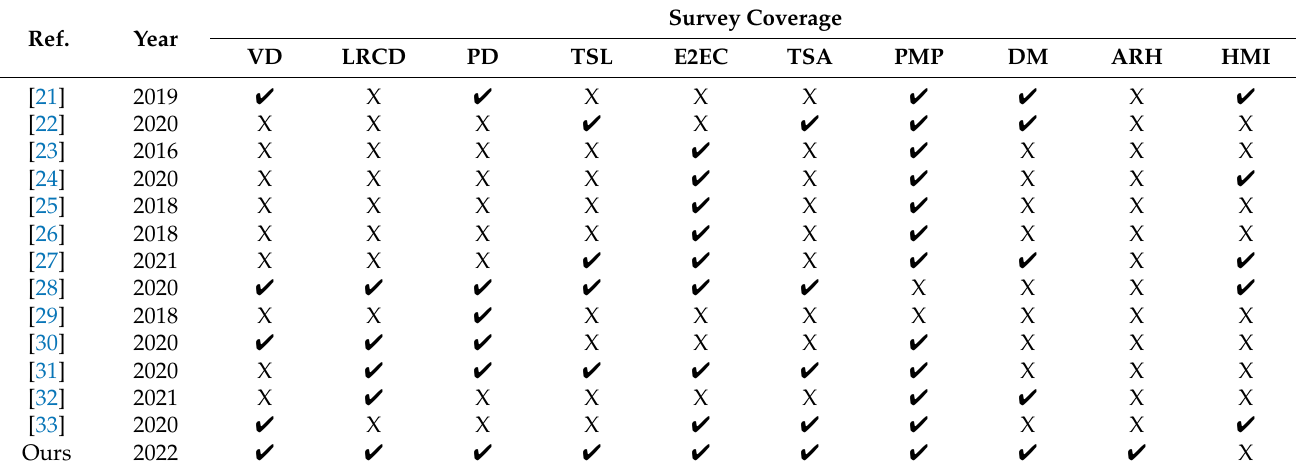
Table 2. Comparison of existing